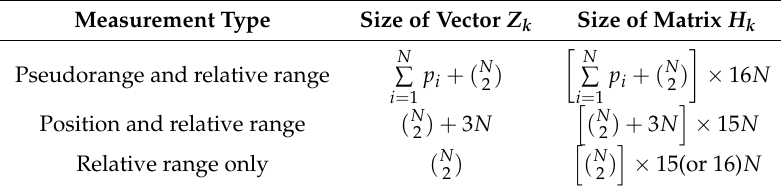
Table 2. Maximum size of joint measurement vector and matrix in a fully connected network. Measurement Type Size of Vector Z